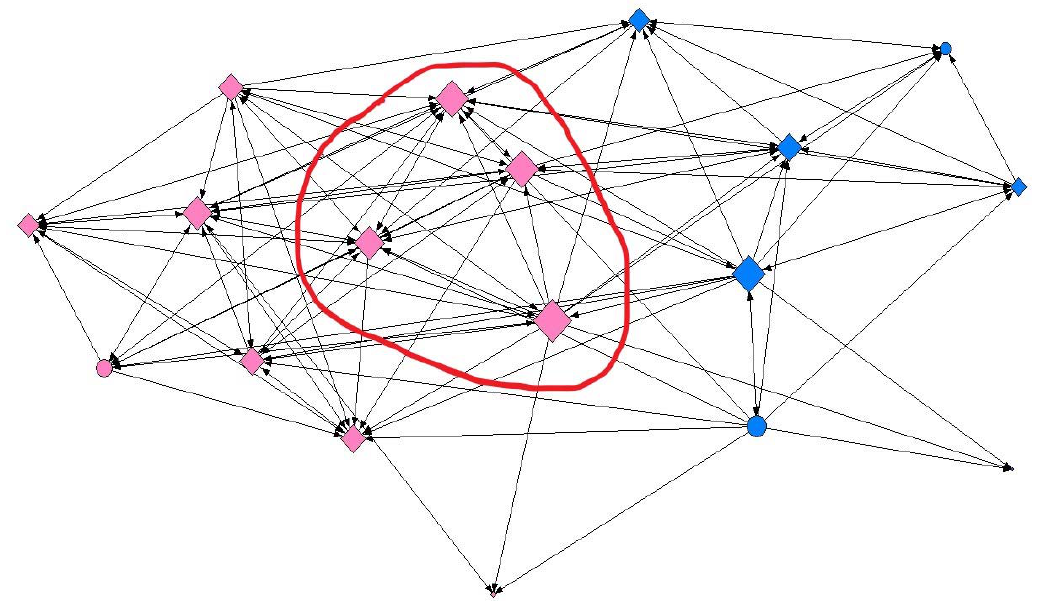
Figure 3. Graphical representation of one of the networks in the study at the intermediate contact intensity level, where node size indicates the degree of ties. Females are shown in pink, males in blue; circles represent individuals with a medium-low SES and diamonds a high SES. As can be seen, female adolescents with a high SES presented greatest centrality according to the degree of ties. Graphs were produced using UCINET software [40].